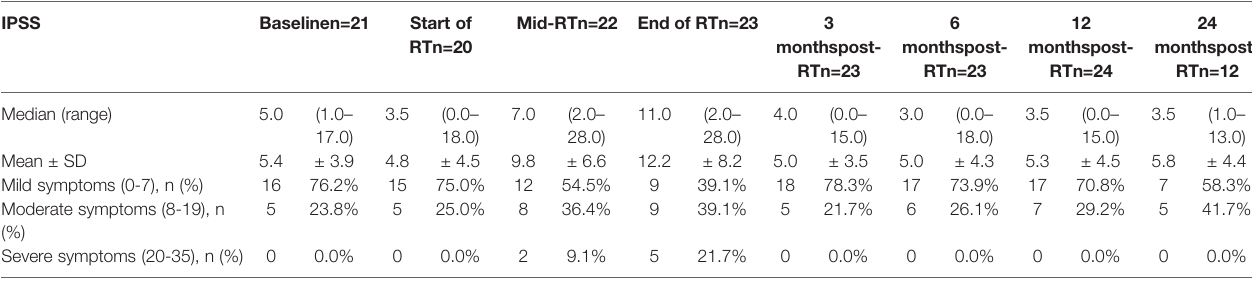
TABLE 4 | Prostate symptoms before, during and after RT, as rated on the